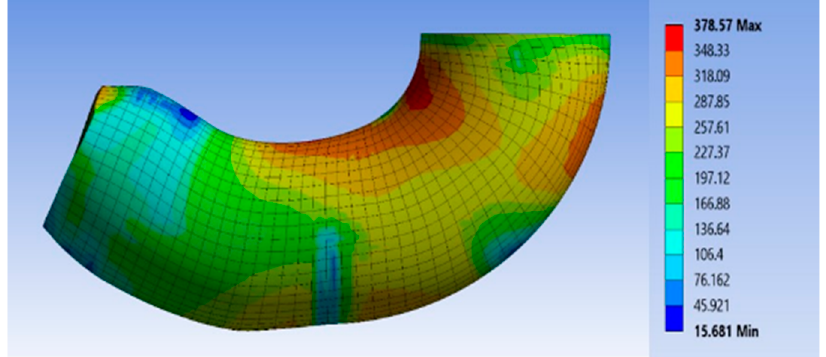
Figure 3. Simulation of effective stresses distribution in Cu samples processed through 1-P at room temperature.